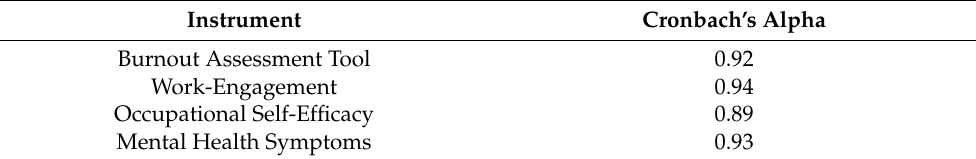
Table 2. Cronbach’s alphas for all measurement